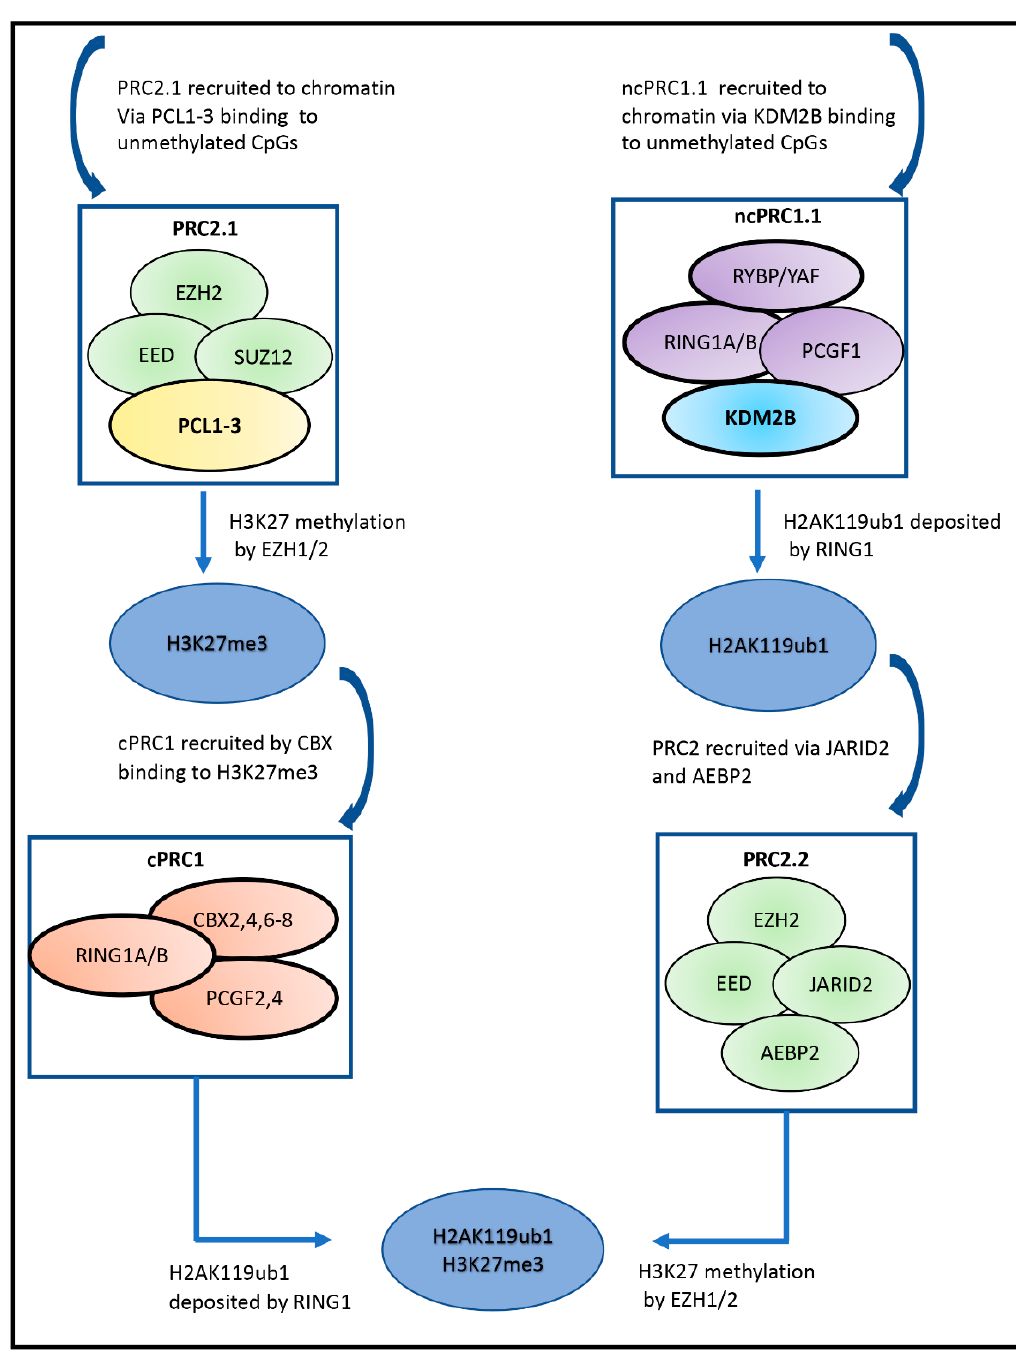
Figure 2. Formation of the K27me3 and H2AK119ub1 marks by components of the Polycomb com- plexes. Polycomb complexes cooperate to form the H3K27me3 and H2A119ub1 marks. ( Left-hand side ) PRC2.1 is recruited to chromatin by PCL1-3 binding to unmethylated CpGs, allowing EZH2 (KMT6A) to methylate H3K27. cPRC1 is then recruited via CBX binding to the H3K27me3 mark, allowing H2AK119 ubiquitination via the E3 ligase RING1A/B. ( Right-hand side ) The ncPRC1.1complex is recruited to chromatin by KDM2B binding to unmethylated CpGs, allowing ubiquitin to be de- posited on H2A119 by RING1A/B. This allows PRC2.2 to be recruited via Jarid1B and AEBP2 and the formation of the H3K27me3 mark by